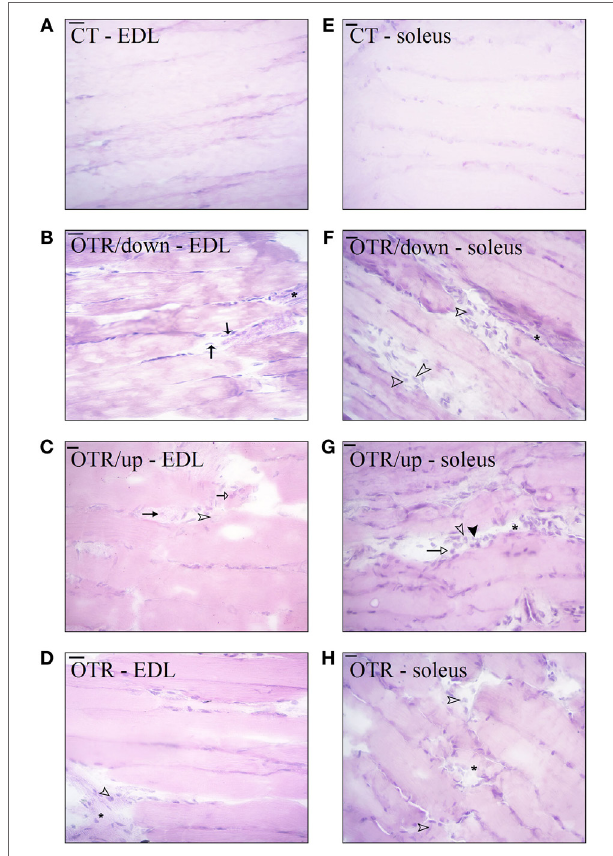
FigUre 3 | Histological analysis of extensor digitorum longus (EDL) and soleus longitudinal sections from control (CT) (a,e) , downhill running-based overtraining (OTR/down) (B,F) , OTR/up (c,g) , and OTR (D,h) . Data correspond to n = 6 mice. CT: sedentary mice. OTR/down: overtrained by downhill running. OTR/up: overtrained by uphill running. OTR: overtrained by running without inclination. *Micro-injuries with polymorphonuclear infiltrated. pyknotic leukocytes. neutrophils. lymphocytes.